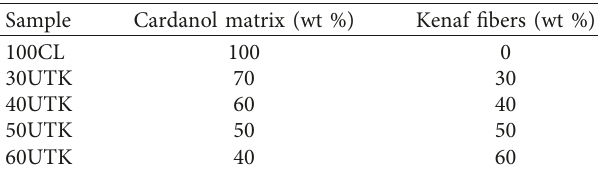
Table 1: Biocomposites